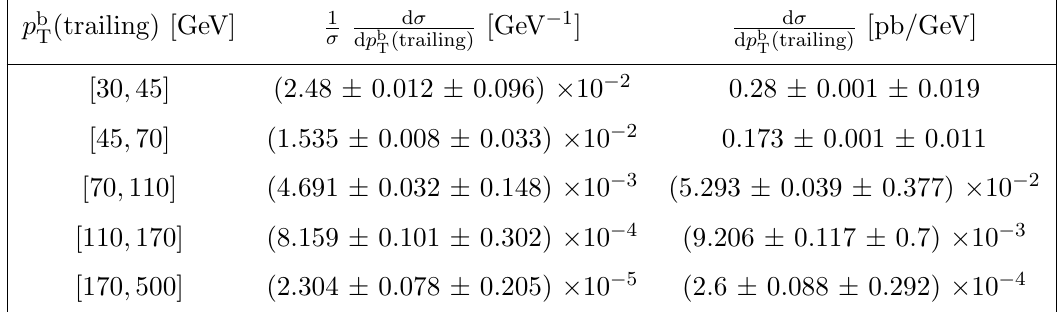
Table 42 . The measured di(cid:11)erential cross section and bin boundaries for each bin of the normalized and absolute measurements of the tt di(cid:11)erential cross section at particle level in the (cid:12)ducial phase space as a function of p b (trailing) are tabulated. T